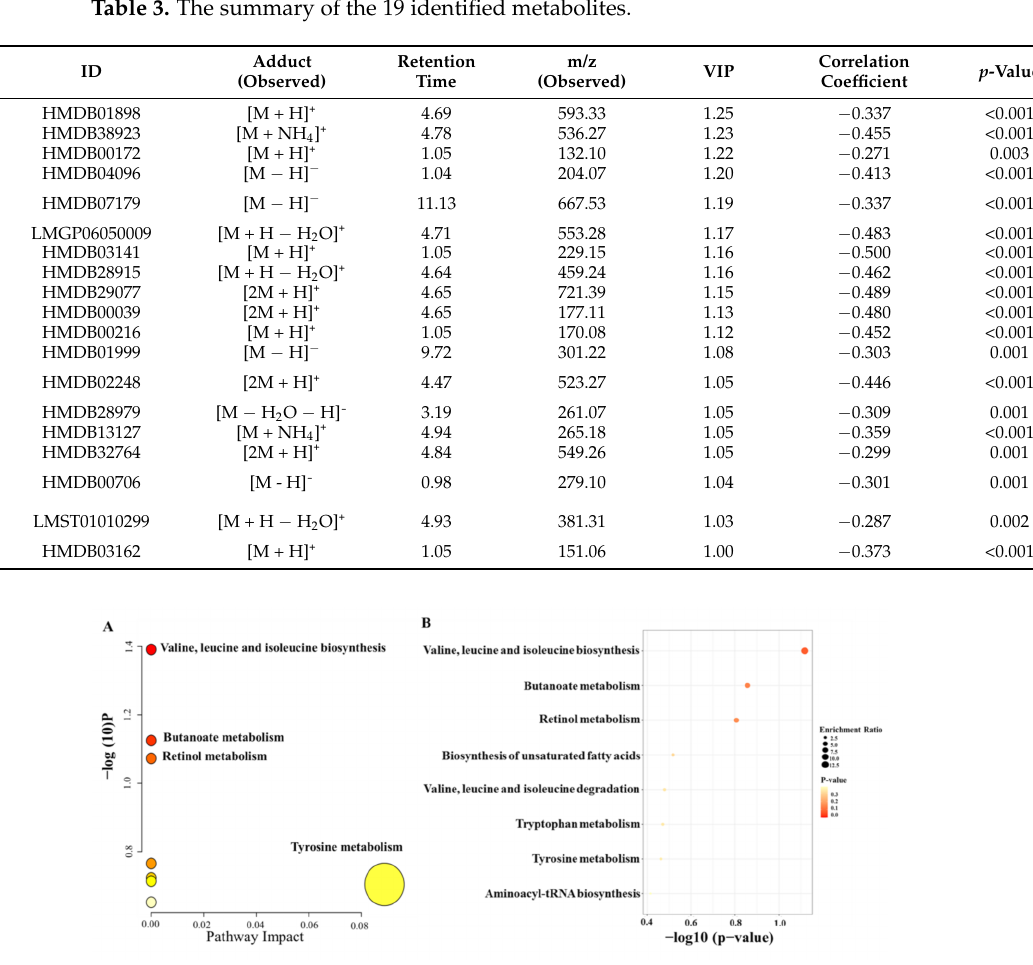
Figure 4. Summary plots of pathway analysis ( A ) and over-representation enrichment analysis ( B ) by MetaboAnalyst (http://www.metaboanalyst.ca, accessed on 12 November 2021) with 19 metabolites selected from the second PLS model. Table 4. Parameter estimation of multinomial logistic regression and 95%